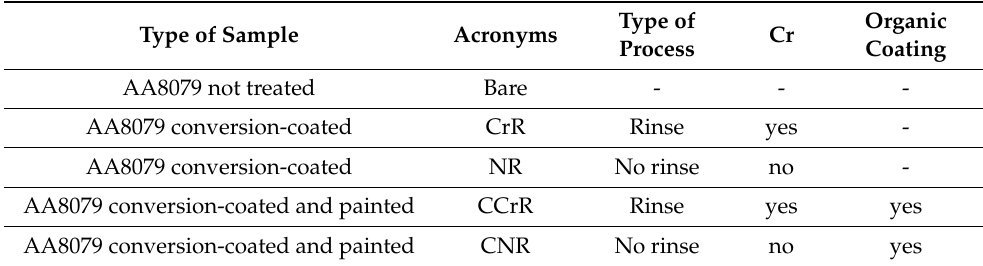
Table 3. Samples’ acronyms and the materials and processes used to make them.